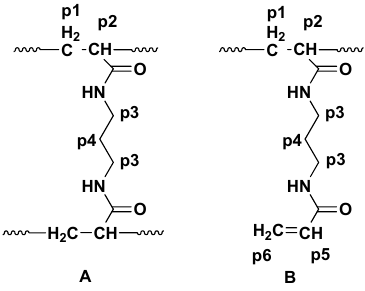
Figure 1. A = dendritic units, B = linear unit, terminal unit.